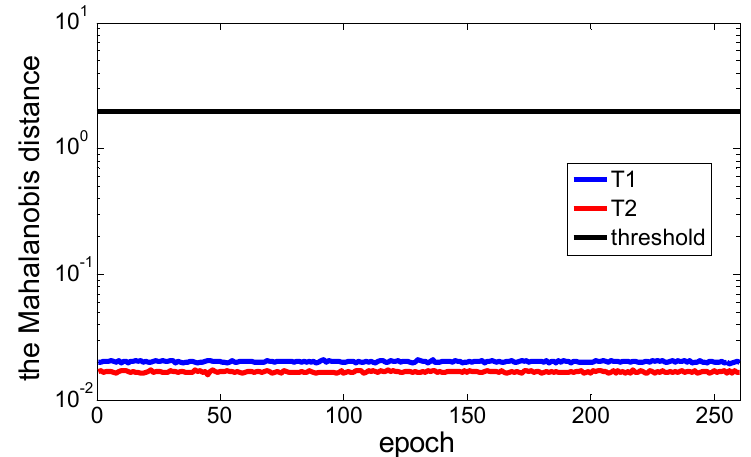
Figure 10. The hypothesis test based on Mahalanobis distance.